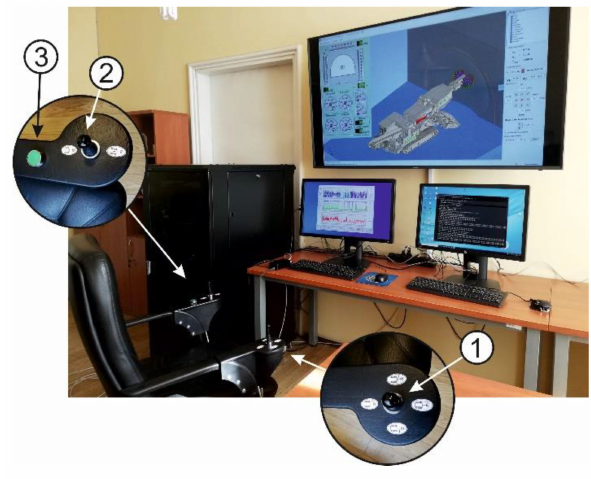
Figure 11. Operator Station in the test version: 1—joystick controlling the boom movement; 2—joystick controlling the roadheader’s travel; 3—motor switch in the drive of the cutting heads. Communication between the control elements of the Operator Station and Workstation #1 is based on the DLP-2232M-G adapter. This module enables data transmission with the use of UART/FIFO, Bit-Bang IO, JTAG, and SPI protocols, among others [34]. It provides 16 digital inputs/outputs (GPIO), to which keypads located in the arranged Operator Station are connected (Figure 12).